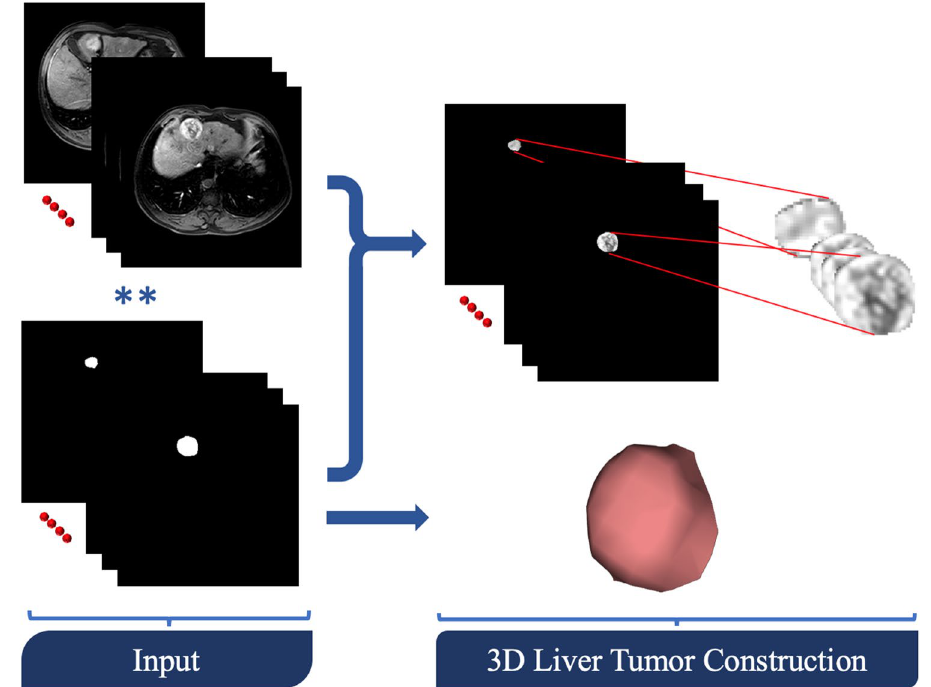
Figure 2. Liver tumors segmentation and 3D objects